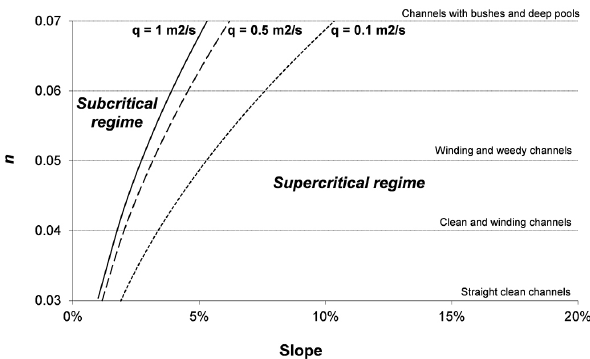
Fig. 3. Froude regime in normal conditions as a function of the unitary discharge q , gully slope S , and n Manning roughness